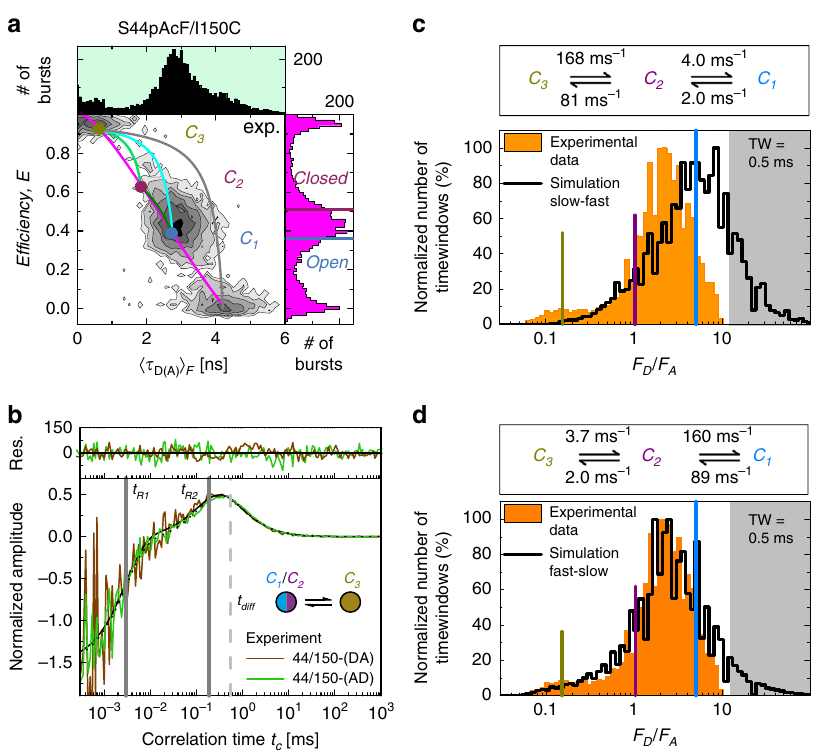
Fig. 3 Kinetic connectivity. a The FRET-ef fi ciency, E , and fl uorescence lifetime of D in the presence of A, 〈 τ D(A) 〉 F , of the DA-labeled T4L variant S44pAcF/ I150C (or wt**) is shown in the two-dimensional MFD-histograms (center) with the one-dimensional projections of E (right) and 〈 τ D(A) 〉 F (top). The magenta line (static FRET-line) represents the molecules with a single conformation. The dynamic FRET-lines represent the molecules changing their conformational state under monitoring. The limiting states (circles) of the dynamic FRET-lines (C 1 , blue; C 2 , purple; C 3 , yellow) are identi fi ed by eTCSPC (see Fig. 4). The dynamic FRET-lines are shown in dark green (C 1 – C 2 ), cyan (C 1 – C 3 ), and light green (C 2 – C 3 ) (Supplementary Methods). The gray line represents the trace molecules of high FRET-ef fi ciency with a bleaching A. The FRET-ef fi ciencies of X-ray structures for an open (blue, PDB ID: 172L) and closed (violet, 148L) state (determined by FPS) are shown for comparison and represented as horizontal lines in the FRET-ef fi ciency histograms. b Overlay of the normalized sCCFs (Supplementary Methods Equation (17)) of S44pAcF/I150C-(DA) and S44pAcF/I150C-(AD). The global fi t with other variants shows two relaxation times ( t R 1 = 4.0± 2.3 µ s, t R 2 = 230± 28 µ s) and a diffusion time t diff = 0.54 ms. c , d Overlay of time-window analysis, slow-fast in c and fast-slow in d , respectively. The shaded area in gray indicates the region of donor only. See Supplementary Note 3 for data on the model and the